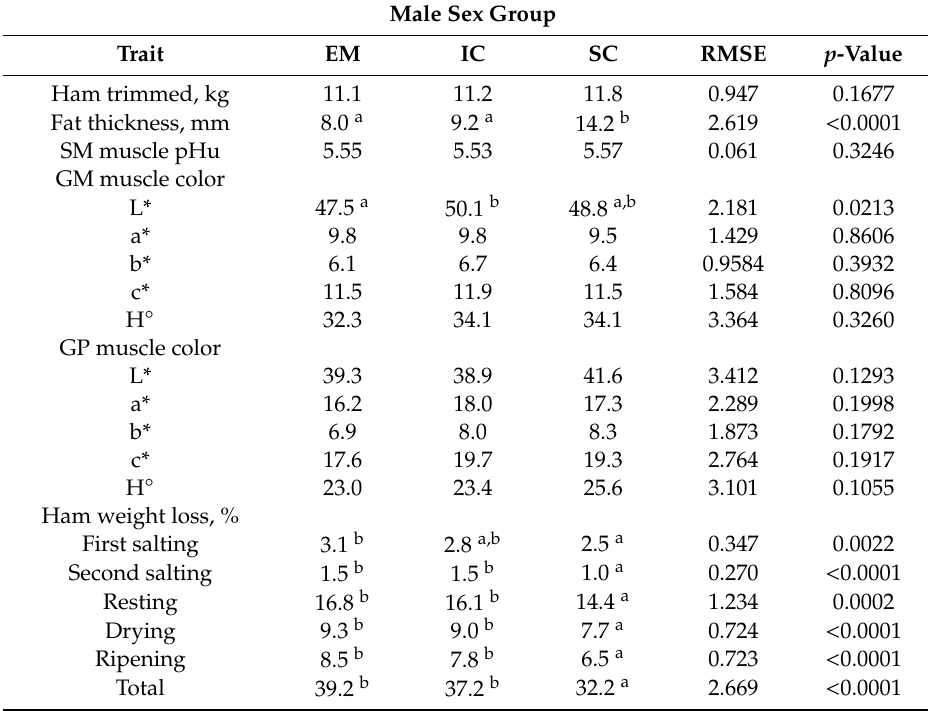
Table 1. E ff ect of male sex group on green ham properties and ham processing weight loss. Male Sex Group Trait EM IC SC RMSE p -Value Ham trimmed, kg